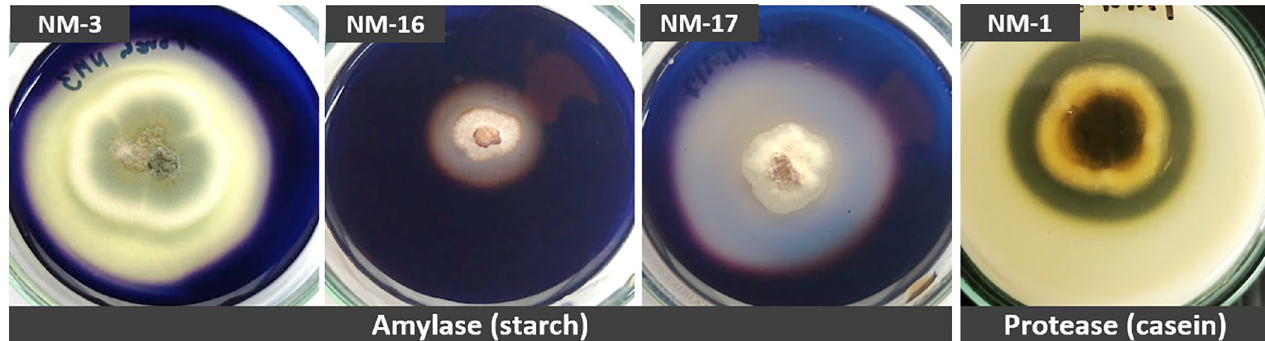
Fig 4. Enzymatic activity test. Four representative samples of the 13 fungal isolates which exhibited good extracellular enzymes activities.